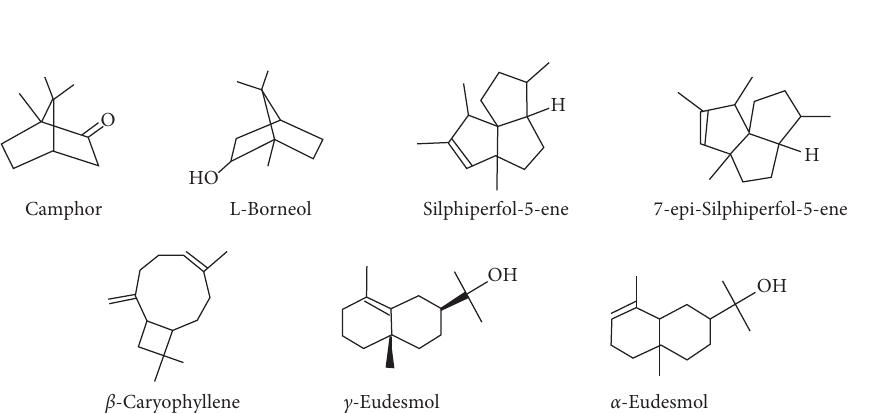
Figure 2: Structure of seven major terpenoids in essential oils from immature and mature leaves of B. balsamifera , selected from the GC-MS